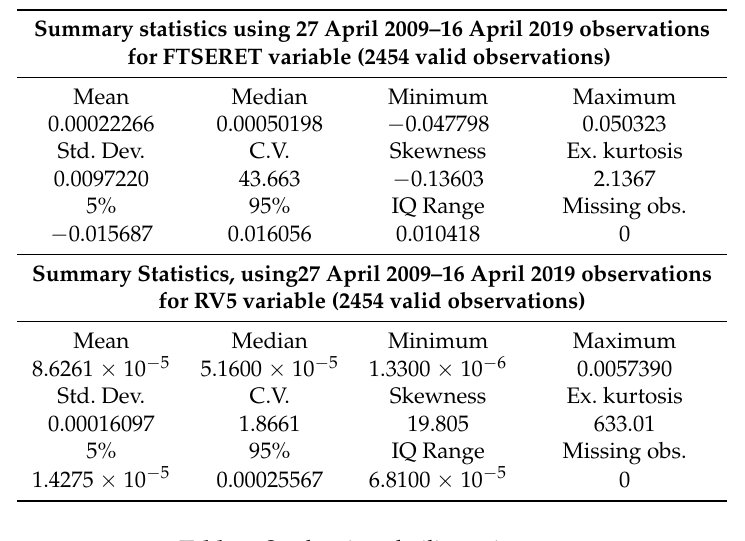
Table 2. Stochastic-volatility